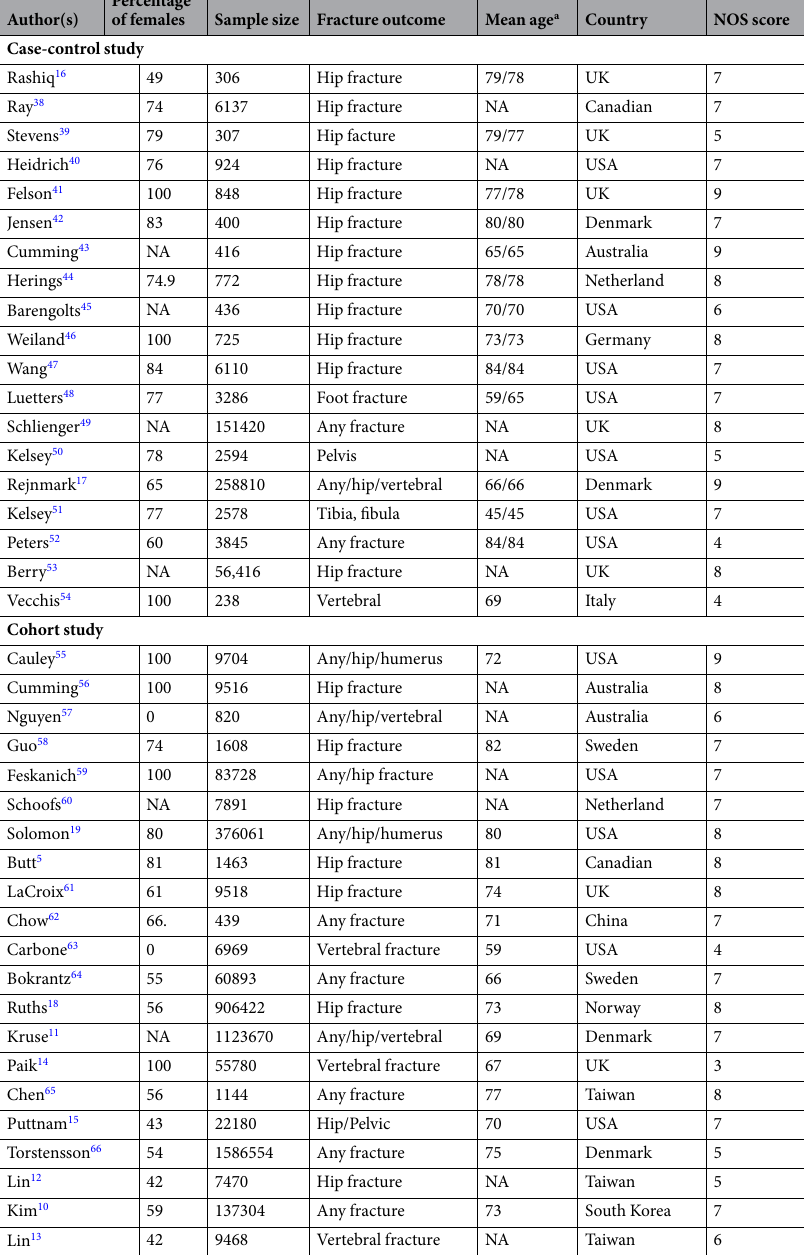
Table 1. Descriptive characteristics for included studies. a Mean ages are reported separately for case-control studies (case/control). Abbreviations: NA: Not available; NOS: Newcastle Ottawa